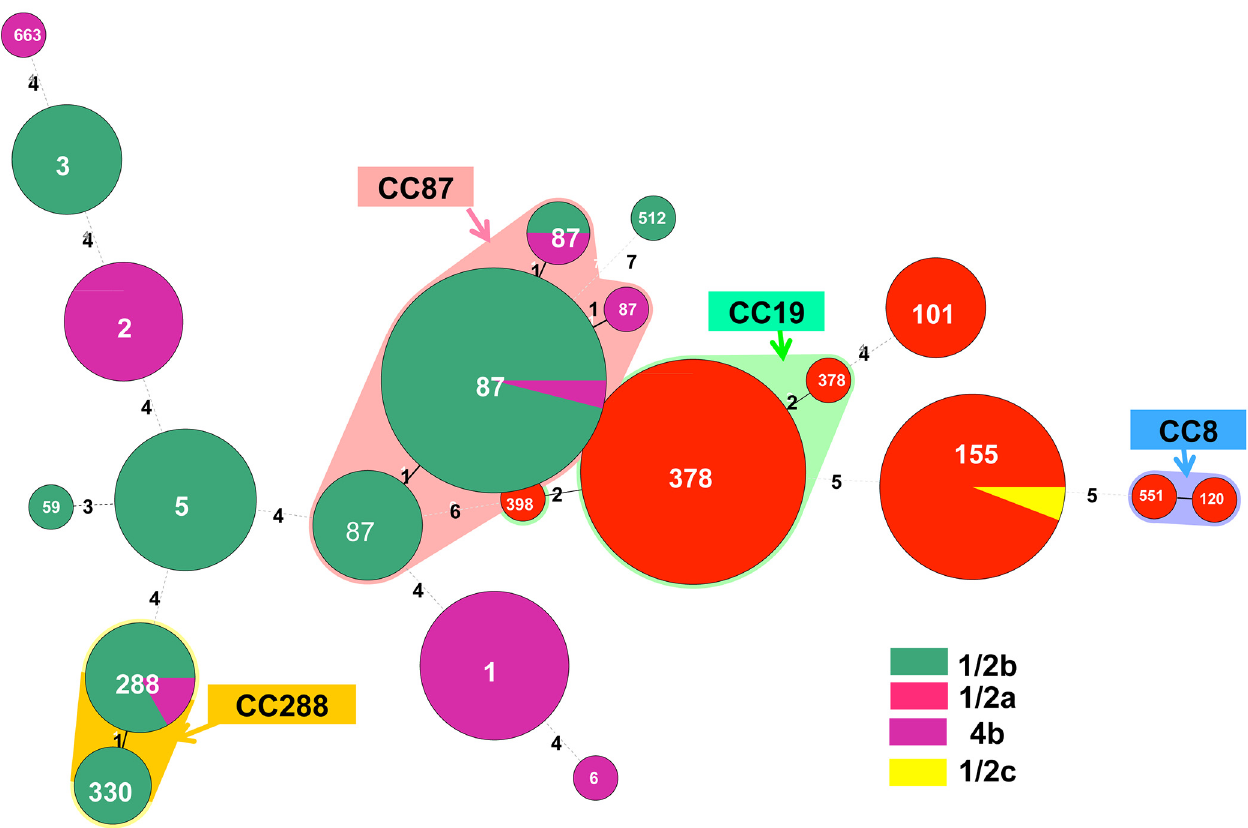
Fig 3. Minimum spanning tree analysis of clinical isolates of 132 L . monocytogenes isolates collected from three medical centers in Taiwan from 2000 to 2013 based on the MLST method of Ragon et al. (10). Circles correspond to PCR serogroups, while numbers on branches are the numbers of allele differences between connected sequence types (STs). The size of each circle is proportional to the number of isolates in each ST. The alignment and minimum spanning tree were created using BioNumerics v5.10. Clonal complexes (STs with single allele difference, CC) are the same as ST in circles, except CC87, CC19, CC8, and CC288 that are shaded in different colors. These CC complexes included CC87 (ST87) (25.8%, n = 34), CC19 (ST378) (19.7%, n = 26), CC155 (ST155) (12.9%, n = 17), CC1 (ST1) (8.3%, n = 11), CC5 (ST5) (7.6%, n = 10), CC288 (ST288 and ST 330) (6.8%, n = 9), CC2 (ST2) (5.3%, n = 7), CC3 (ST3) (4.5%, n = 6), CC101 (ST101) (3.8%, n = 5), CC8 (ST8) (1.5%, n = 2), CC59 (ST59) (0.8%, n = 1), CC6 (ST6) (0.8%, n = 1), CC398 (ST398) (0.8%, n = 1), and singleton (ST663 and ST512) (1.5%, n = 2).